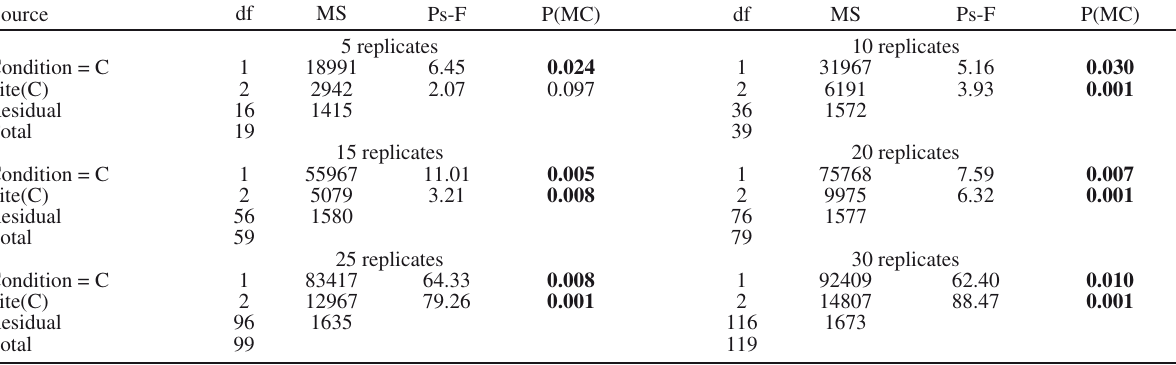
Table 4. – Results of PERMANOVA analyses on morphological groups abundance and composition datasets obtained through the photo- graphic method with different numbers of replicates (5, 10, 15, 20, 25 and 30). MC, Monte-Carlo procedure. Significant effects are in bold. Source df